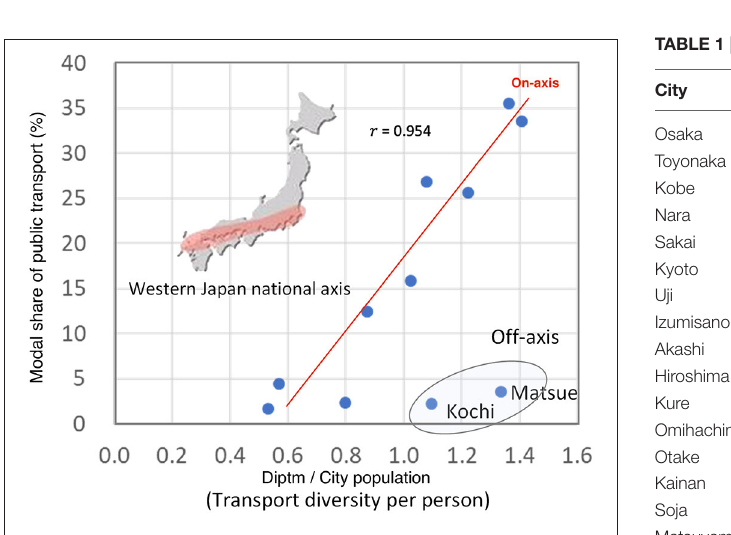
FIGURE 7 | Relationship between the modal share and the average Diptm per person in central cities.